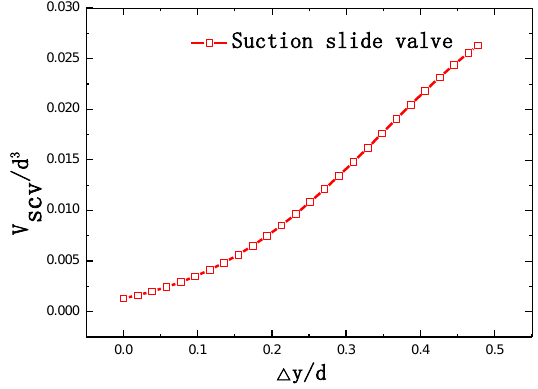
Figure 6. 𝑉 scv /𝑑 13 vs. ∆𝑦/𝑑 1 of suction slide valve. Figure 6. V scv { d 3